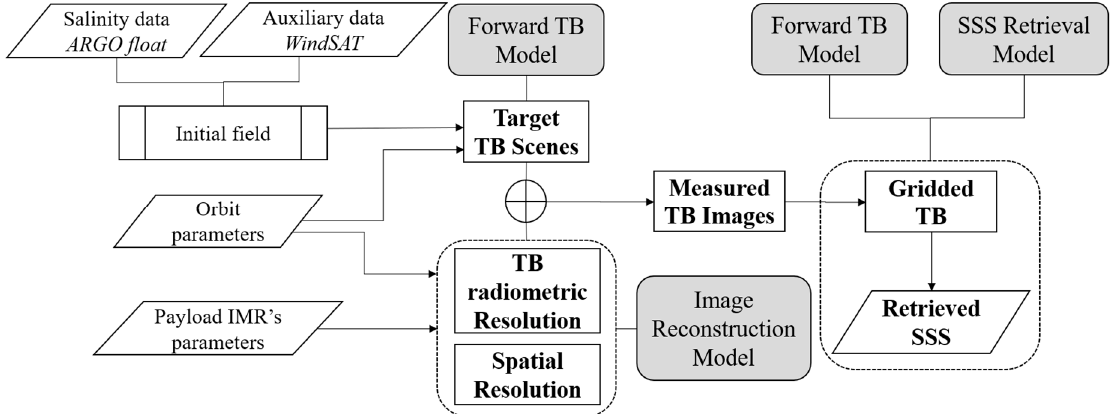
Figure 3. Diagram of the end-to-end simulation of sea-surface salinity (SSS) according to the configuration of the IMR, which consists of three major models highlighted as grey cases (i.e., the TB forward model, the image reconstruction model, and the SSS retrieval model).